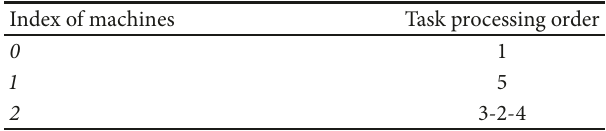
Table 4: Parameter values of PSO algorithm and the proposed algo-